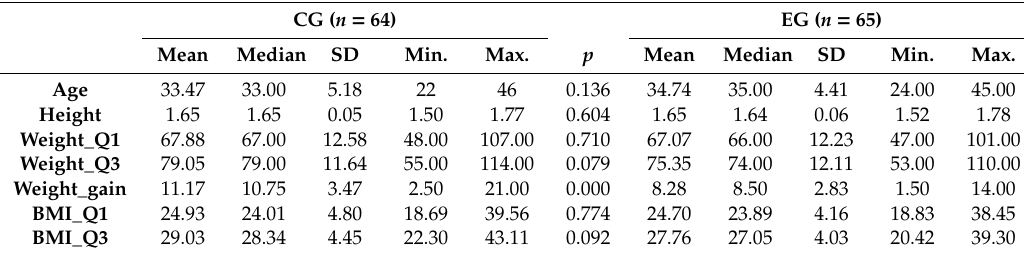
Table 1. Sociodemographic and anthropometric data.